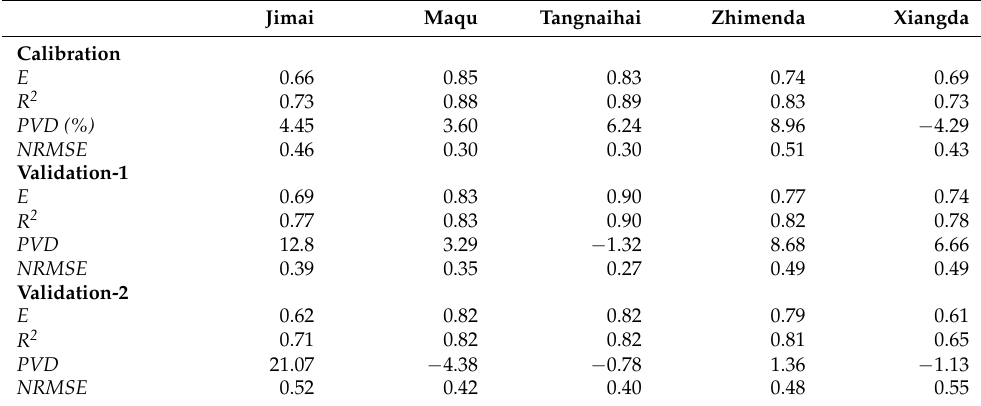
Figure 7. Comparison of observed and simulated streamflow at ( a ) Jimai station on the Yellow River, ( b ) Maqu station on the Yellow River, ( c ) Tangnaihai station on the Yellow River, ( d ) Zhimenda on the Yangtze River, and ( e ) Xiangda on the Lancang River hydrometric stations. Table 5. Performance evaluation of HEC-HMS in the TRHR on a daily basis. Jimai Maqu Tangnaihai Zhimenda